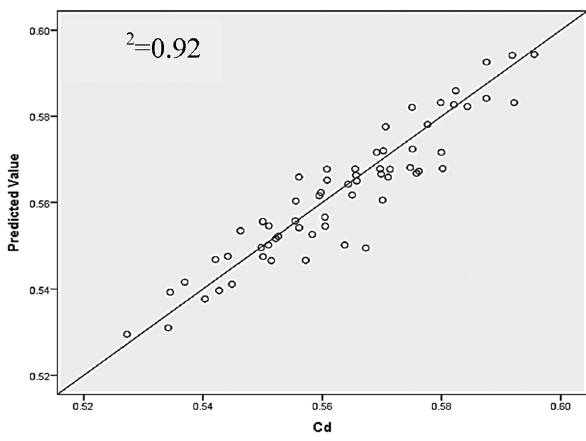
Figure 4: ANN results for the training stage from SPSS V24 software.